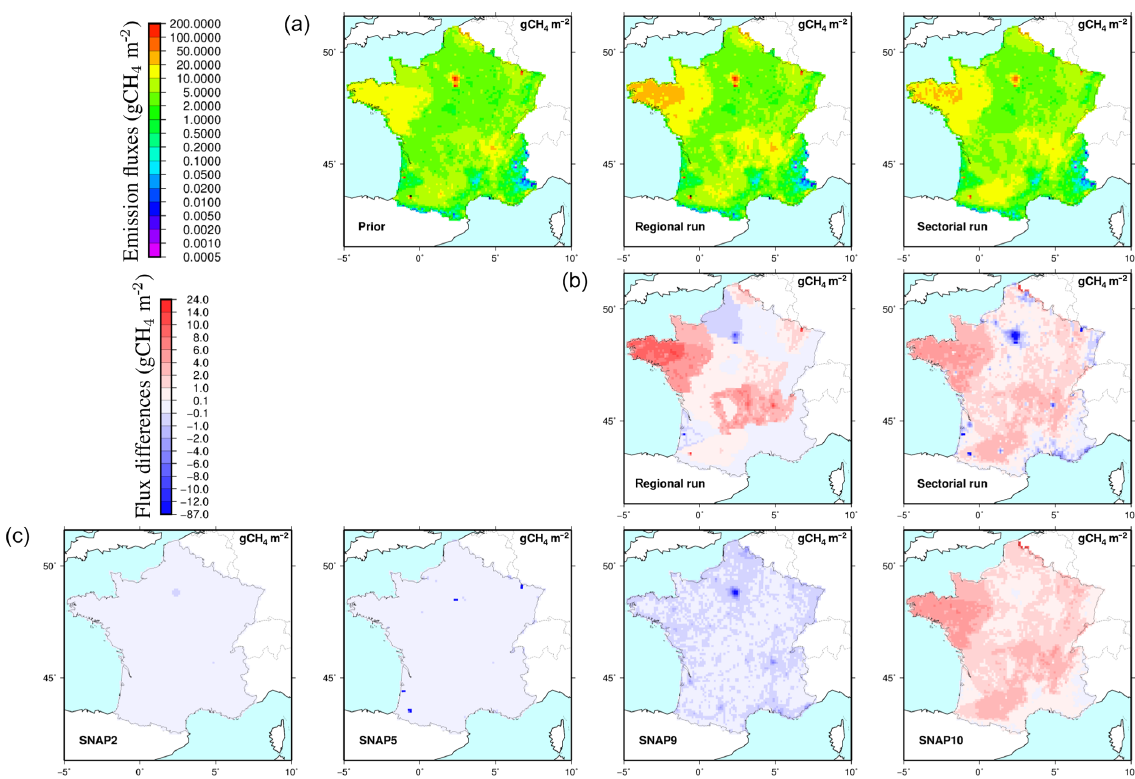
Figure 4. Annual median CH 4 emission fluxes in gCH 4 m − 2 in France ( a , prior from IER, inferred fluxes from the regional and sectorial runs); differences inferred minus prior (b) for the regional and sectorial runs; details for the sectorial run (c) : differences inferred minus prior for the four sectors which are actually seen, SNAPs 2, 5, 9 and